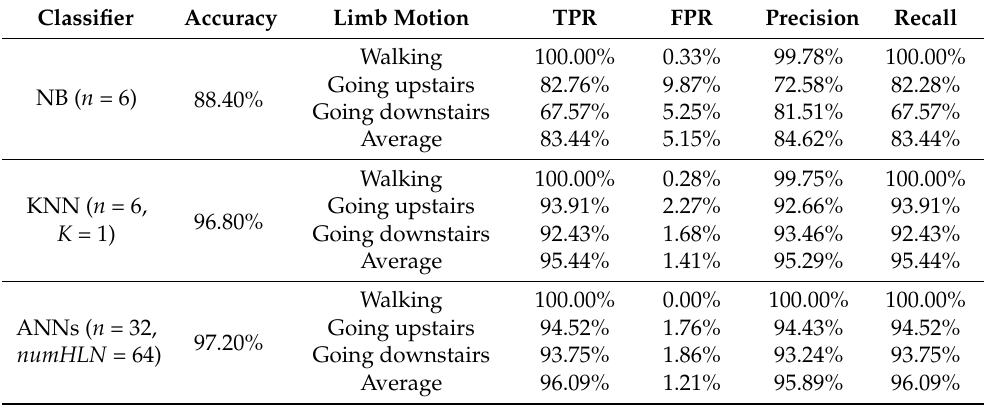
Table 4. Activity recognition results of three classifiers using SU-AIS